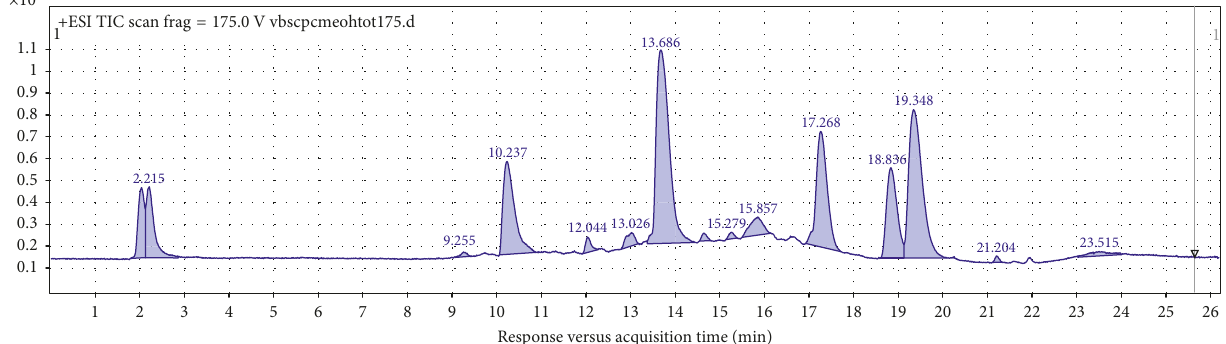
Figure 2: TIC of a sample extract: Berberis cretica methanol root extract in the optimized LC-MS method with BBR at 19.3min, PLM at 18.8min, JTR at 17.2min, OBB at 16.6min, STP at 15.8min, BBM at 15.2min, ARM at 14.6min, and MGN at 13.7